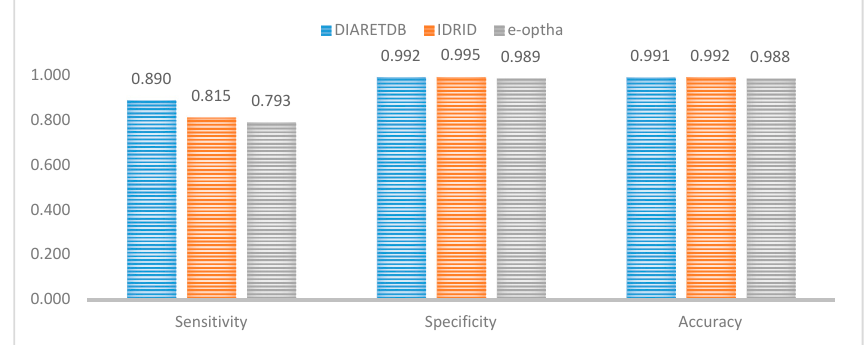
Figure 13. Performance comparison between DIARETDB, IDRID, and e-optha.